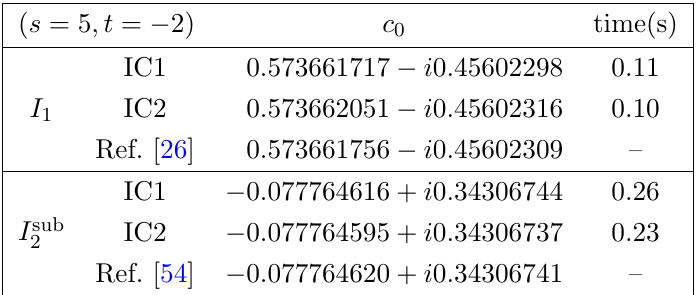
Table 3. The comparison of our numerical results with the analytical ones for the Feynman integral I 1 and I sub